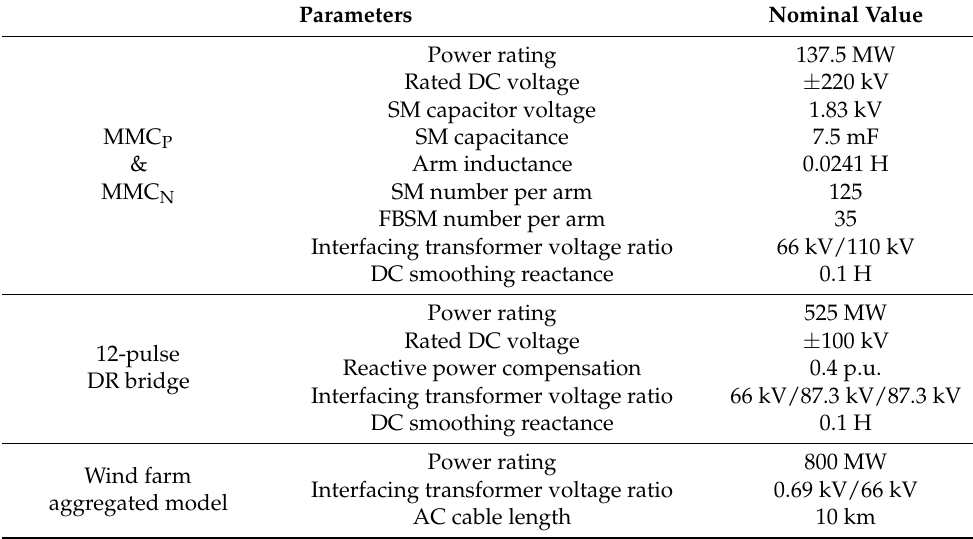
Table 2. Simulated system